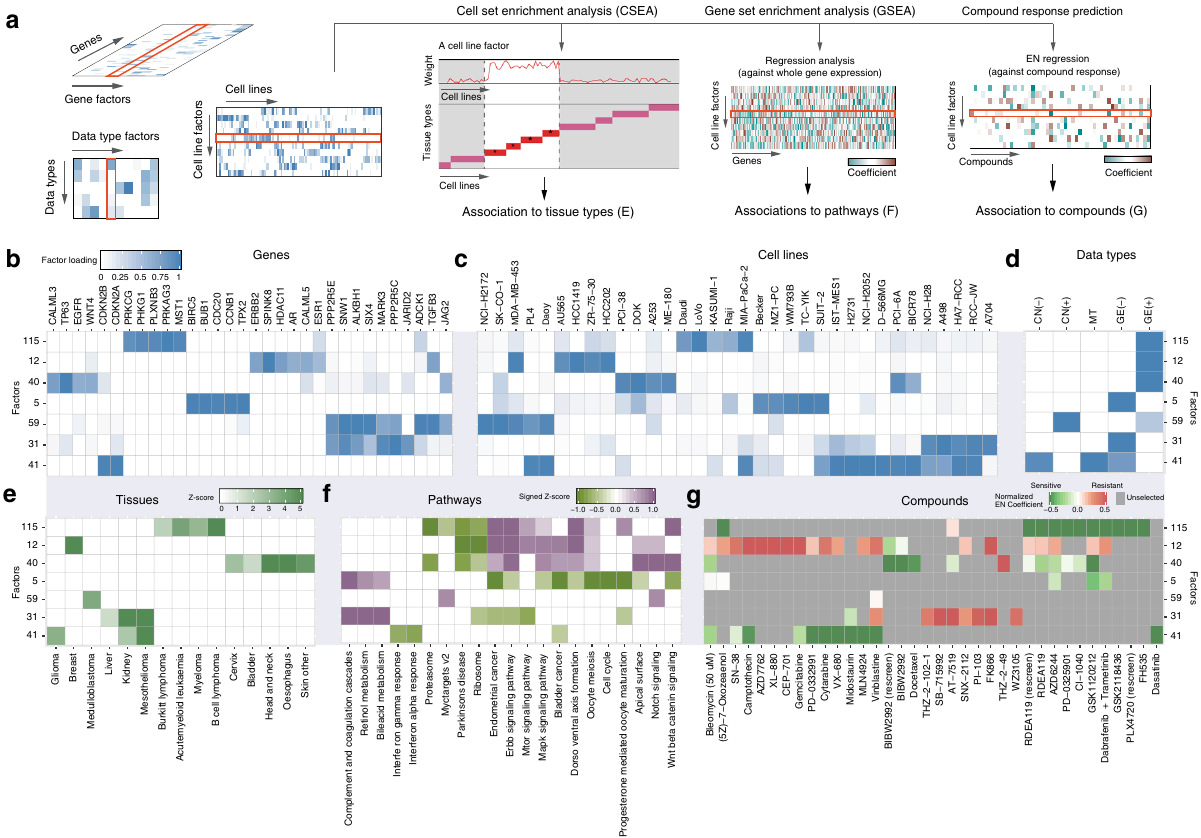
Fig. 2 Interpretation of factors obtained from WON-PARAFAC. a Assessment of tissue types enrichment; gene set enrichment and association to drug responses for cell-factors. b – d ( b ) Gene factor (gene-factor) matrix, c cell line factor (cell-factor) matrix, and d data type factor (DT-factor) matrix visualized in heatmaps, for the selected factors and their top associated genes, cell lines, and data types, respectively. Factor loading is indicated by color gradient, which is the strength of the association. e – g Associations between the selected factors and tissue types ( e ), enriched pathways ( f ), and compounds ( g ) in heatmaps where their color gradient represents the signi fi cance of association in Z -scores, signed Z -scores, and coef fi cients from EN, respectively. The sign in Z -score indicates up or down-regulation of pathways, and sign in EN coef fi cients indicates sensitivity (negative) or resistance (positive) to